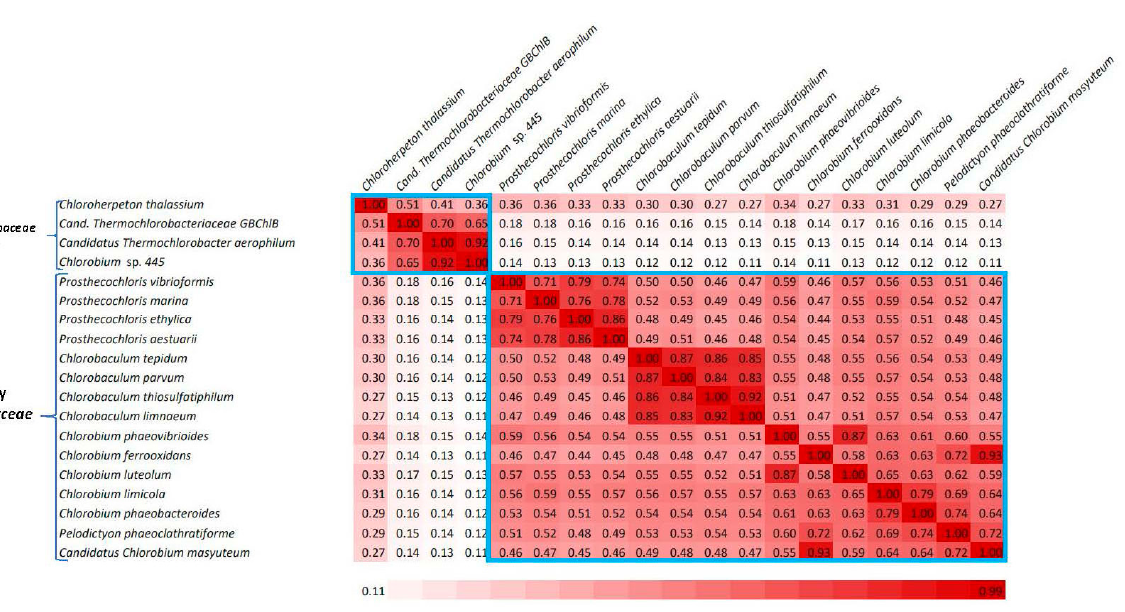
Figure 3. Pairwise comparison matrix showing the averages of the percentage of conserved proteins (POCP) between different genome-sequenced Chlorobia species. Genome pairs sharing higher POCP values are shaded more darkly (red). The regions of the matrix corresponding to the species from the two families are labeled.